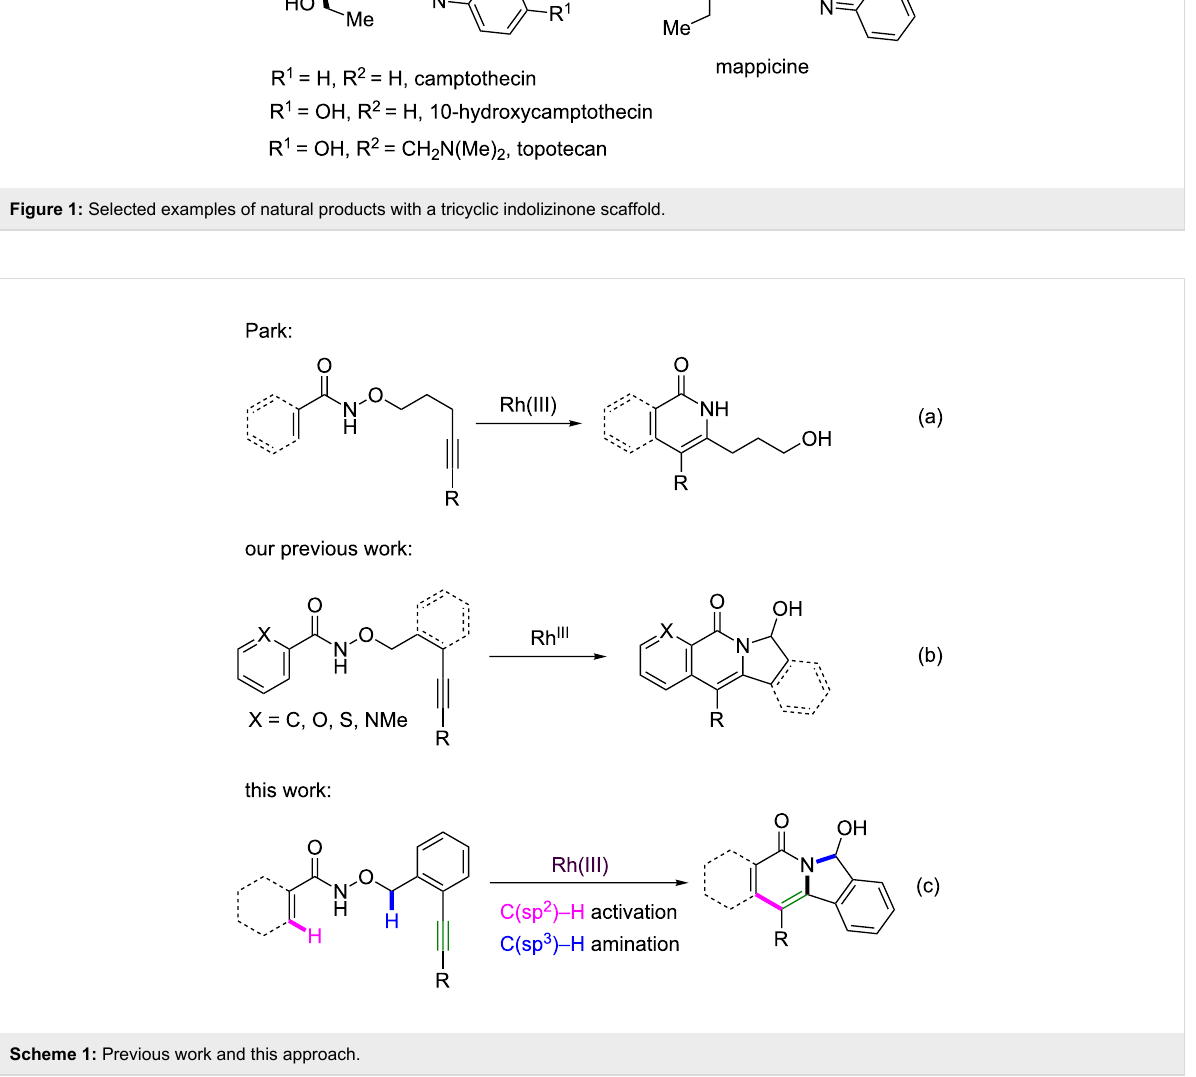
Scheme 1: Previous work and this